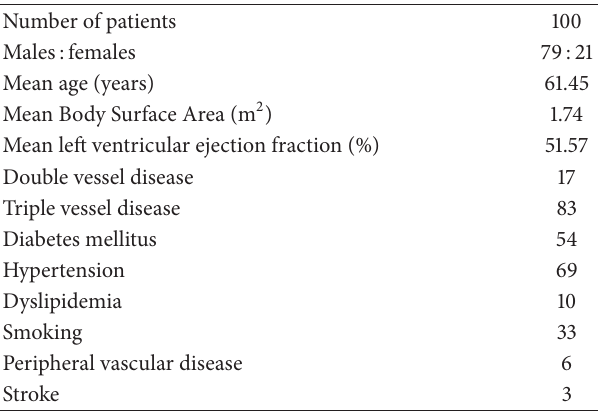
Table 1: Patient